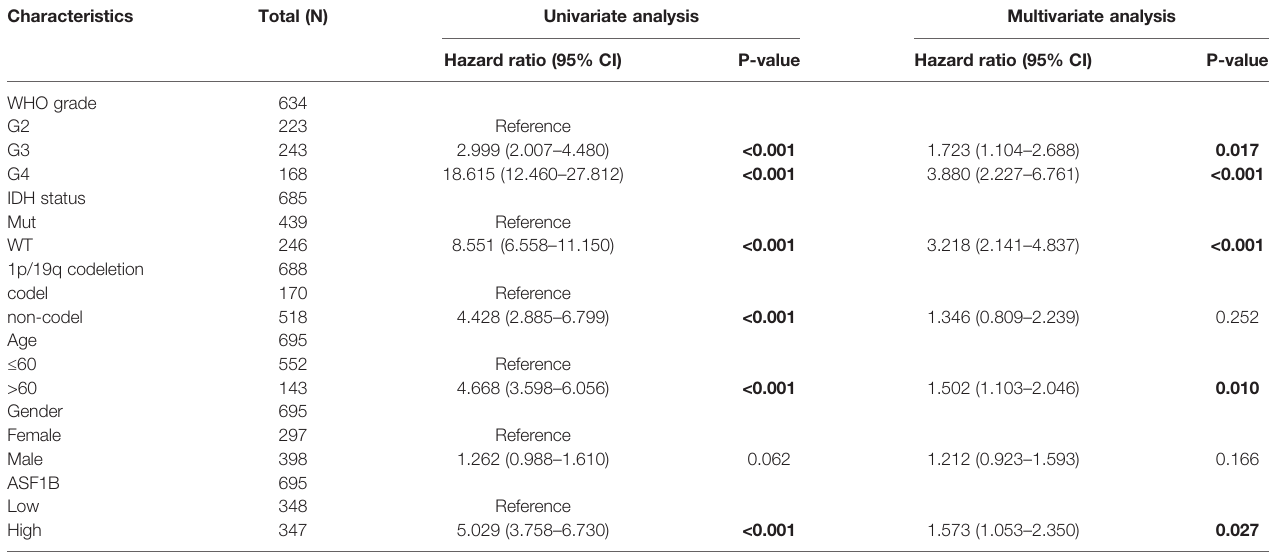
TABLE 5 | Univariate and multivariate analysis of clinical factors that correlate with OS of glioma patients.